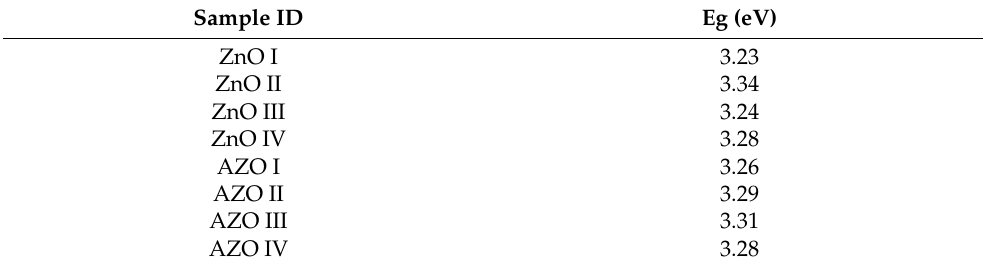
Table 5. The energy bandgap values for the respective